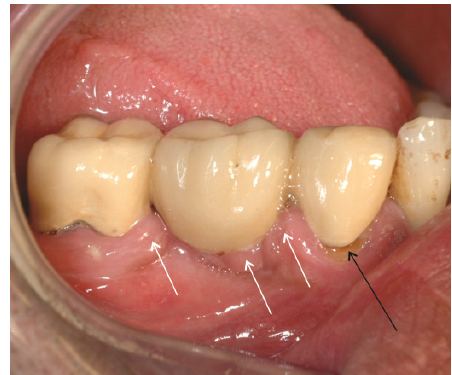
Figure 4. Secondary caries at the crown margin (black arrow) caused by accumulation of biofilm in the crevice between crown and tooth. Hyperplastic gingiva (white arrows) due to increased plaque accumulation in the connector area of the fixed partial denture. The connector area of the bridge has a bulky design which complicates interdental hygiene (photo: Marit